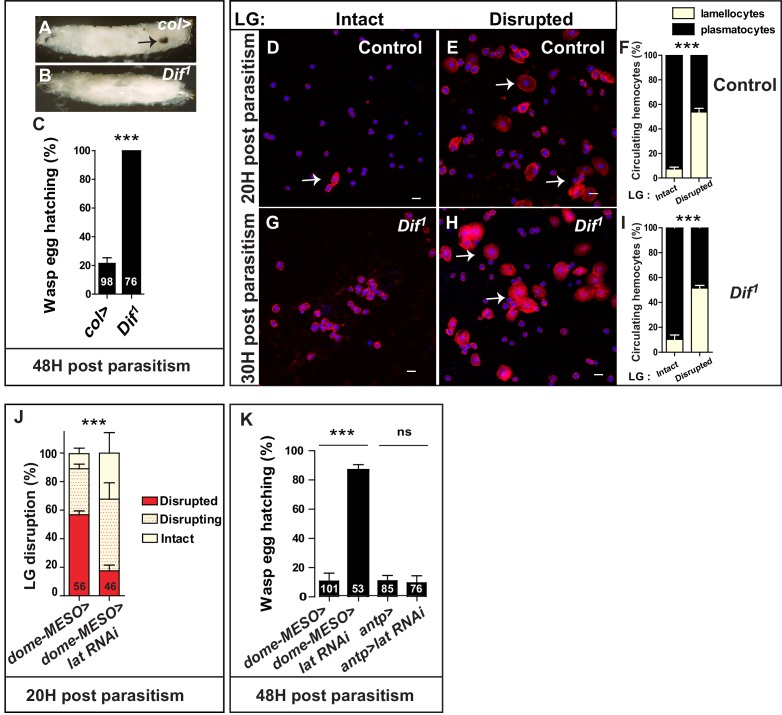
Dif, lymph gland lamellocyte differentiation and lymph gland disruption are required for wasp egg neutralization.(A, B) Brightfield images of control (col>, A) and Dif1 mutant larvae 48 hr post parasitism (B). The arrow indicates a melanotic capsule. (C) Quantification (%) of wasp egg hatching in control (col>) and Dif1 mutant. In this and subsequent similar analyses, numbers of (infected) larvae analyzed are indicated on histograms. (D–I) Phalloidin (red) staining of circulating hemocytes in control (hml>, D, E) and Dif1 mutant (G, H) just prior (D, G) and following (E, H) lymph gland disruption. Arrows indicate discoidal-shaped lamellocytes that are larger than plasmatocytes. (F, I) Quantification (%) of circulating plasmatocytes and lamellocytes in control (F) and Dif1 mutant (I). Blue, TOPRO3. (J) Quantification of lymph gland disruption (%) in control larvae (dome-MESO>) and when latran is down-regulated in lymph gland progenitors (dome-MESO > lat RNAi). (K) Quantification of wasp egg hatching in control larvae (dome-MESO>) or (antp>) and when latran is down-regulated in lymph gland progenitors (dome-MESO > lat RNAi) or in PSC cells (antp > lat RNAi). Error bars correspond to SEM, ***p<0.001 and ns (not significant) (Pearson’s Chi-squared test).10.7554/eLife.25496.010Figure 2—source data 1.Wasp egg hatching quantification.10.7554/eLife.25496.011Figure 2—source data 2.Circulating hemocyte quantification.10.7554/eLife.25496.012Figure 2—source data 3.Lymph gland disruption quantification.10.7554/eLife.25496.013Figure 2—source data 4.Wasp egg hatching quantification.